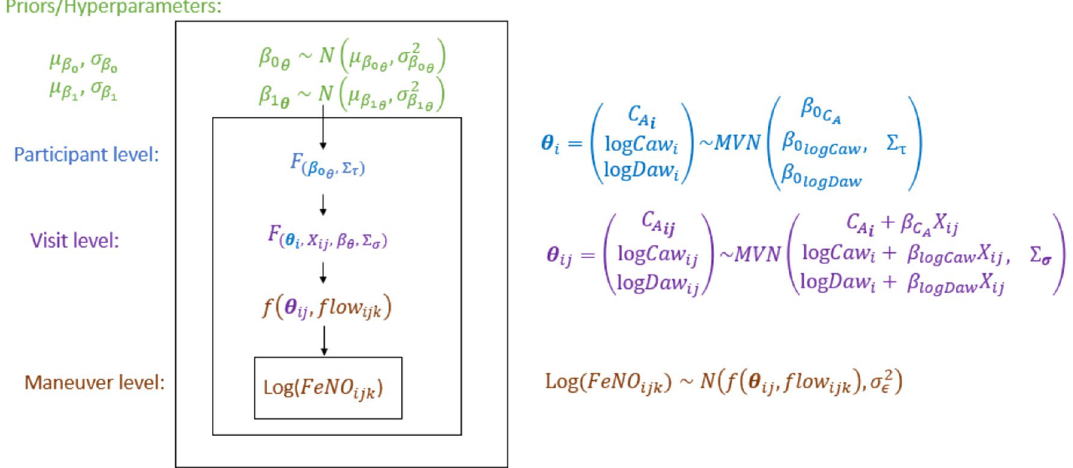
Figure 1. Diagram of the hierarchical model structure relating Longitudinal FeNO measurements at multiple flow rates to NO parameters that are a function of a potential determinant X (e.g., air